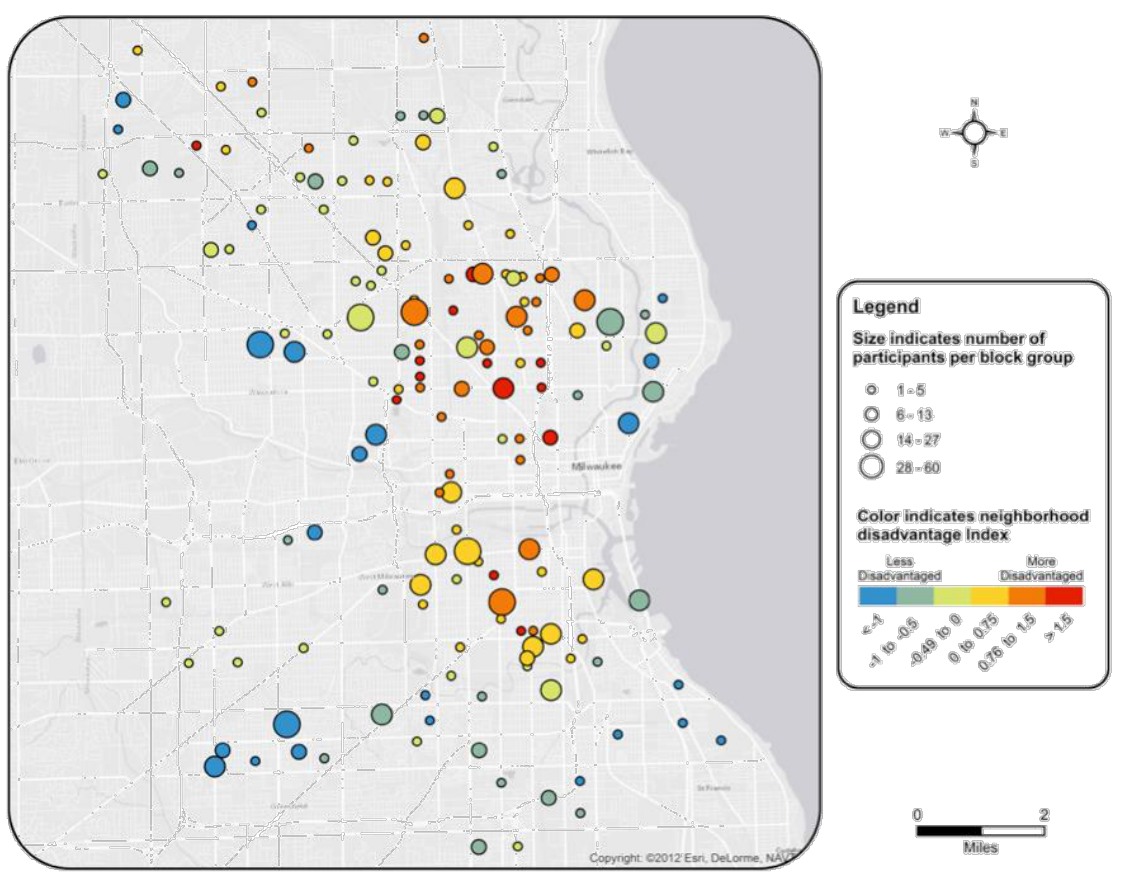
Figure 1: Location and neighborhood disadvantage of households that participated in the Milwaukee Area Renters Study .